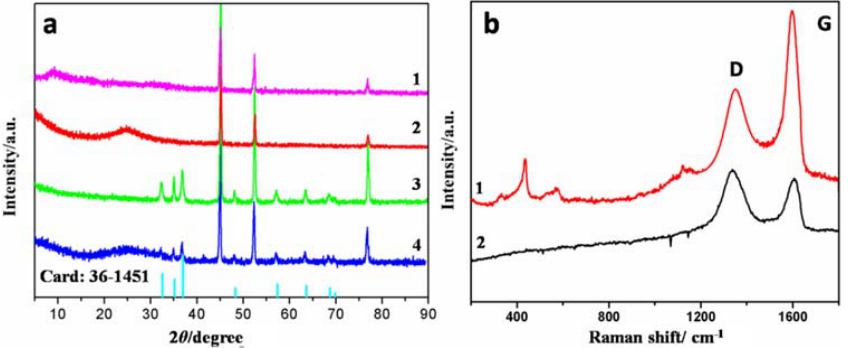
Figure 2. ( a ) XRD of graphene oxide (GO)/NF (curve 1), GO/NF (curve 2), ZnO@NF (curve 3) and ZnO/RGO@NF (curve 4); and ( b ) Raman of ZnO/RGO@NF (curve 1) and GO (curve 2).